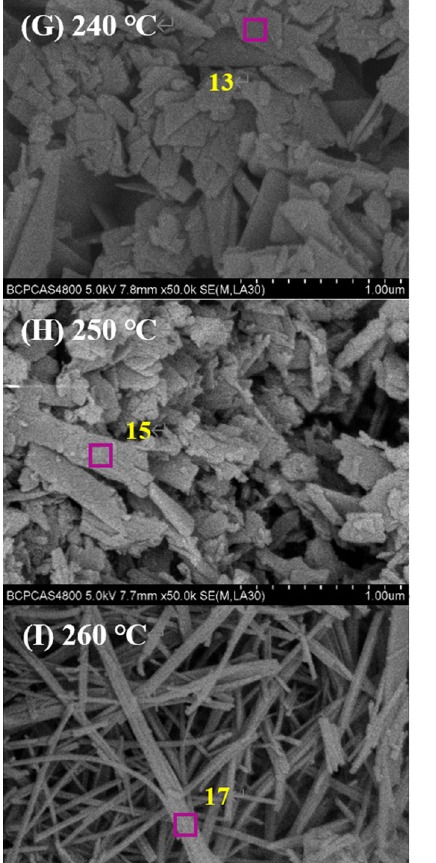
Table 3. EDS analysis results for different microcosmic region.